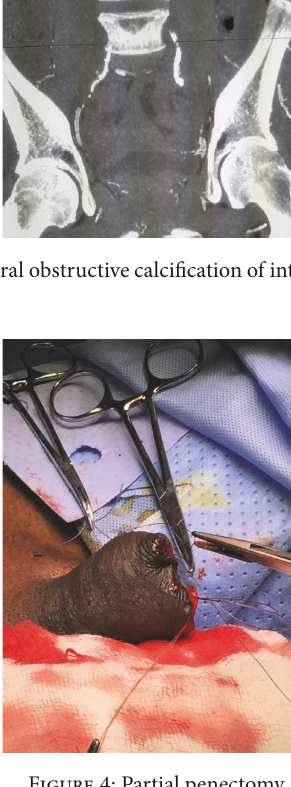
Figure 2: Calcification of the penile vessels and tissues.